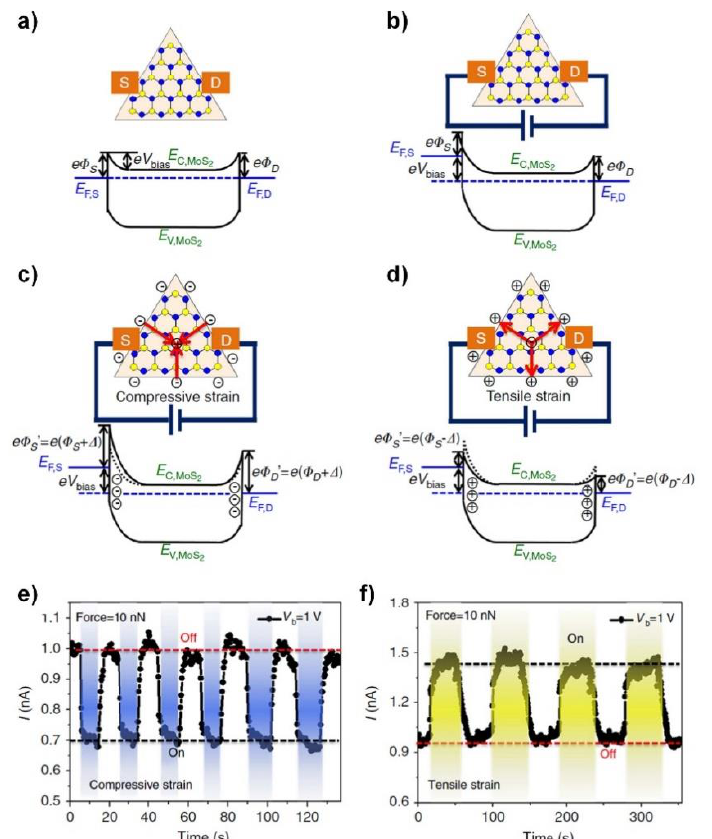
Figure 9. Transition metal dichalcogenide (TMDC) monolayer for piezoelectric device applications. ( a – d ) Energy band edge diagrams of the MoS 2 -monolayer-based piezoelectric device: ( a ) without bias voltage; ( b ) with external bias to the drain electrode; ( c ) with compressive strain applied to the monolayer; ( d ) with tensile strain applied to the monolayer. The red arrows represent the polarization direction. E F , E C , E V , V bias , and ∆ represent the Fermi level, conduction band, valence band, external bias, and introduced piezopotential, respectively. Reproduced from [59] with permission from Springer Nature Limited. Copyright 2015.